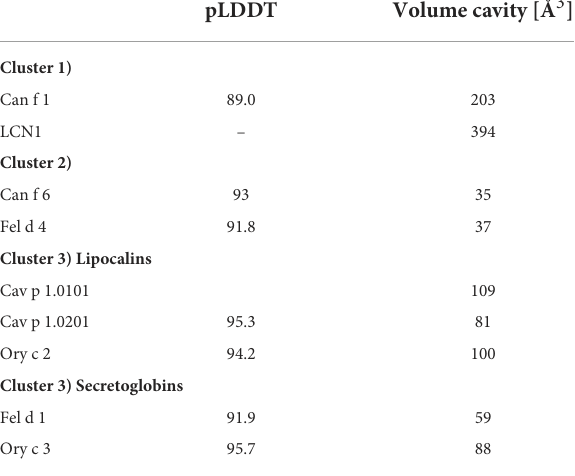
TABLE 4 Average predicted local distance difference test (pLDDT) of AlphaFold models and cavity volumes computed by CASTp of lipocalin and secretoglobin respiratory allergens and human